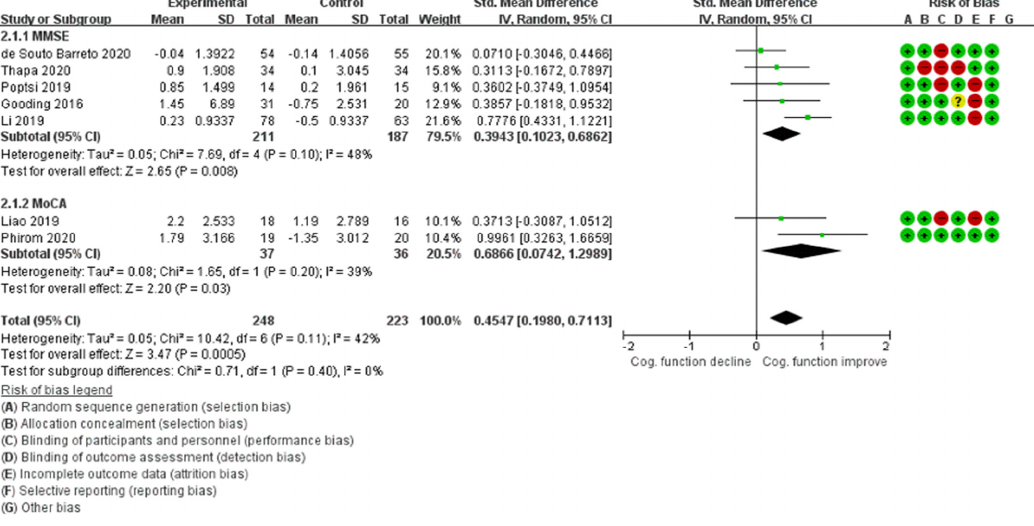
Figure 4. Forest plots of global cognition of all selected studies.